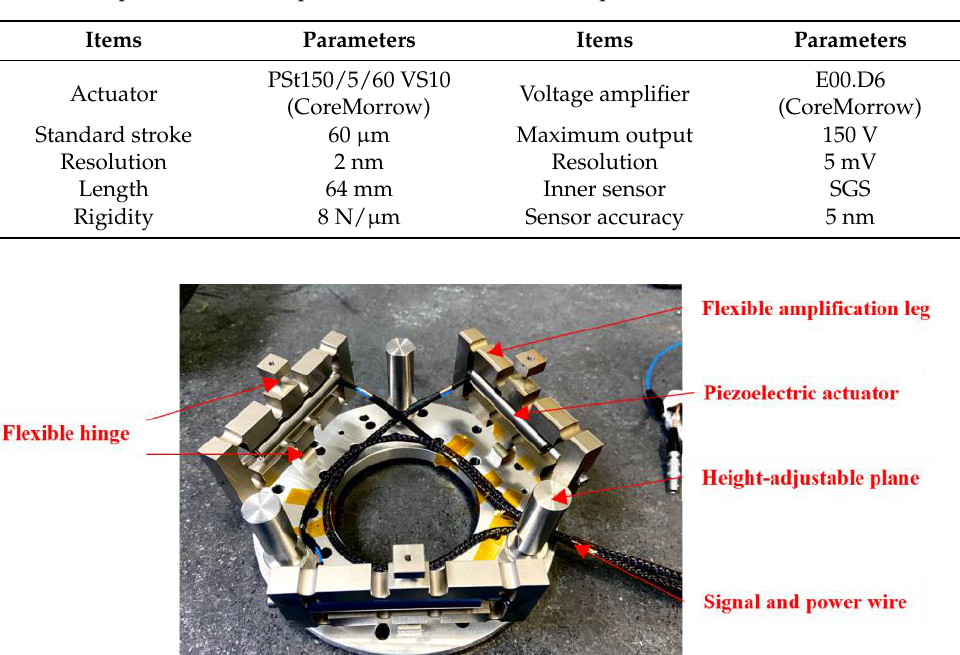
Table 2. The parameters of the piezoelectric actuators and amplifier.